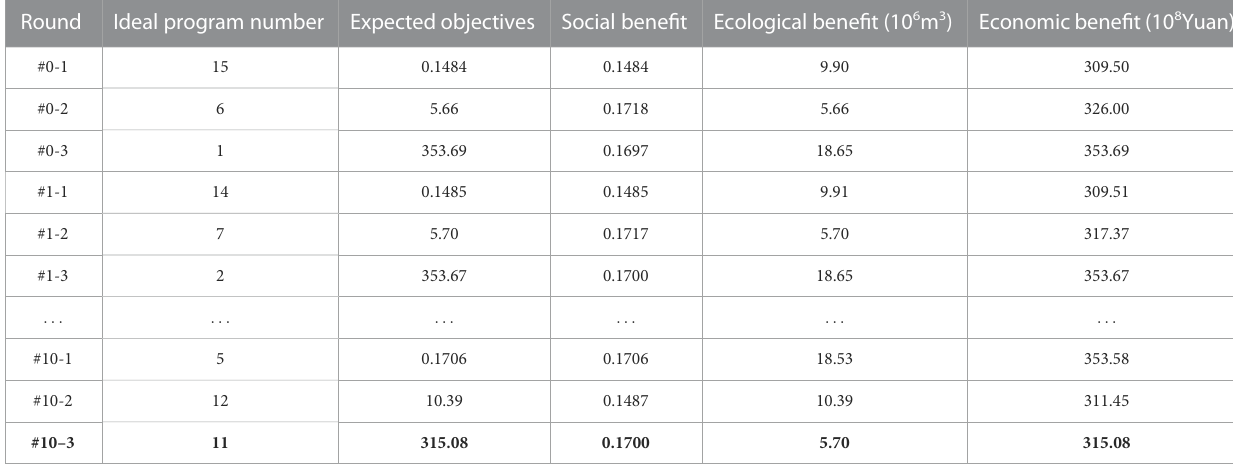
TABLE 2 The process of optimizing water resource allocation at city and county levels in normal fl ow year. Round Ideal program number